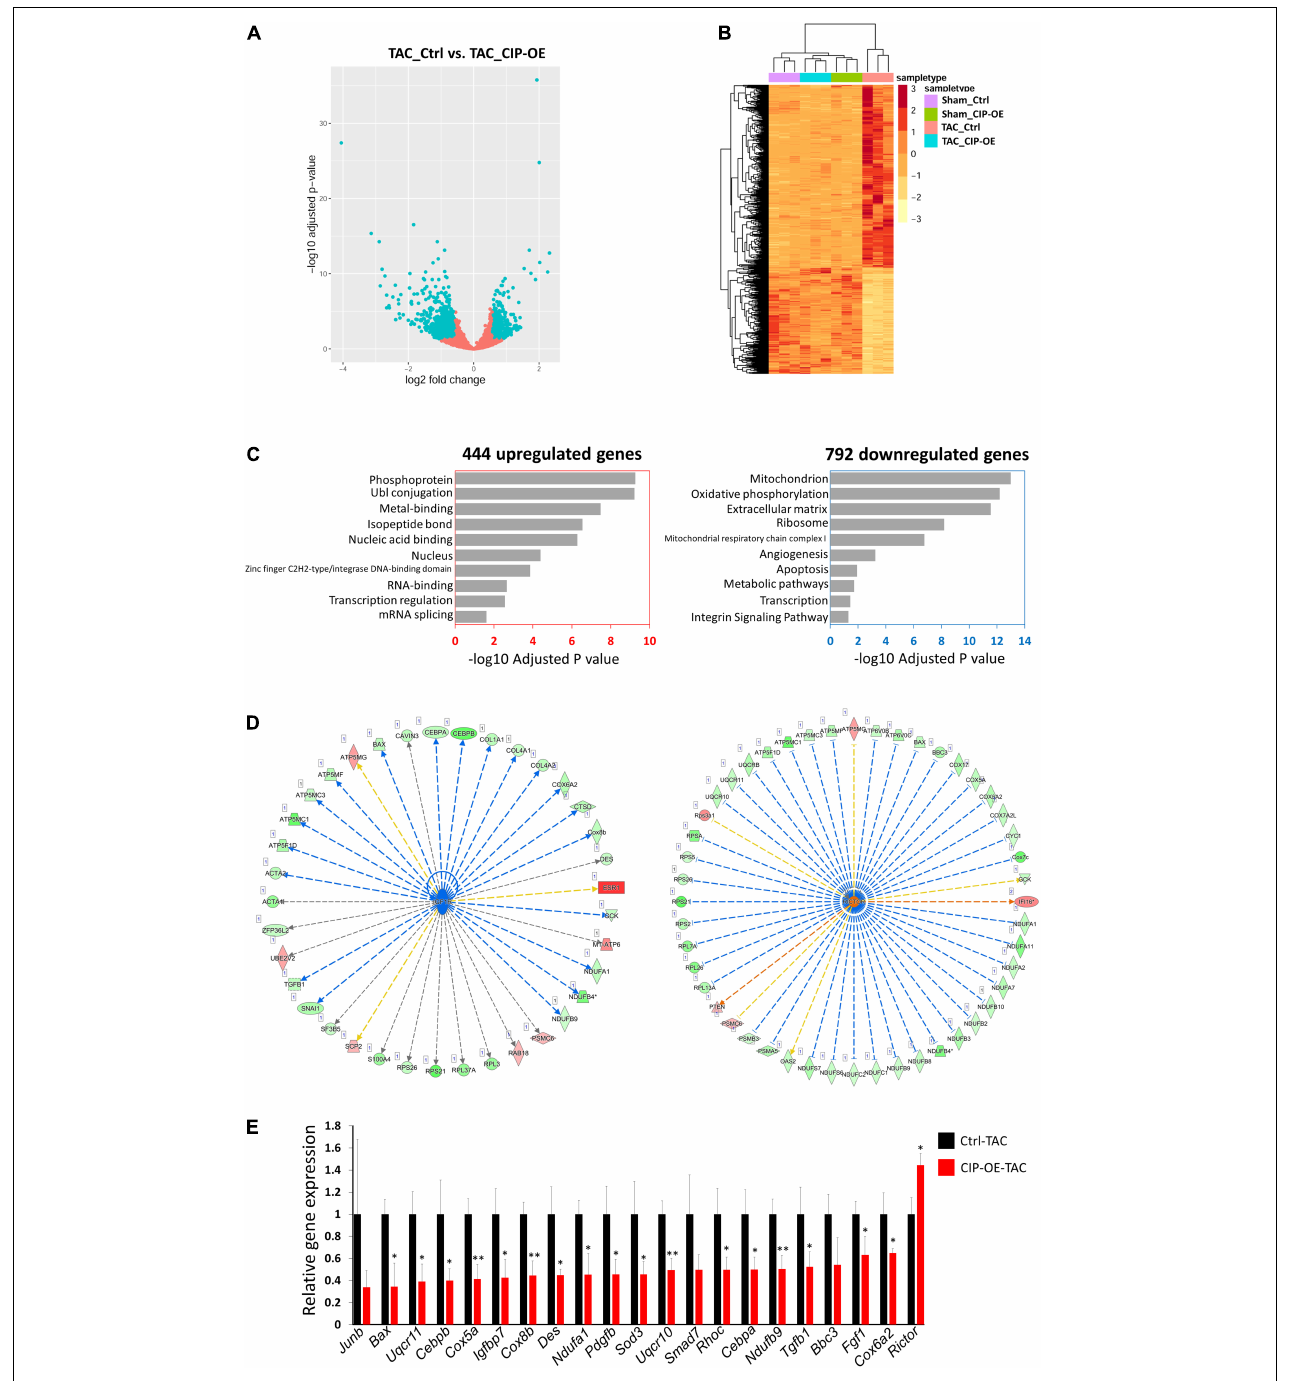
FIGURE 5 | IGF1R and mTORC2 signaling pathways mediates the function of CIP in cardiac protection. (A) A volcano plot of all detected genes in RNA-seq. Each dot represent one gene and the blue dots indicate dys-regulated genes in TAC-CIP-OE hearts comparing to TAC-Ctrl hearts. (B) A hierarchical clustering heatmap of 1,236 dys-regulated genes in all groups. (C) Gene ontology analysis of 444 up-regulated ( p < 0.05) and 792 down-regulated ( p < 0.05) genes in TAC-CIP-OE hearts. The GO terms are ranked by the adjusted P values. (D) Ingenuity Pathway Analysis (IPA) of upstream regulators of dys-regulated genes in CIP-OE heart after 8 weeks of TAC operation. Genes in green indicate their expression in CIP-OE heart is down-regulated. Genes in red indicate their expression in CIP-OE heart is up-regulated. Blue lines indicate that the dysregulation of upstream regulator lead to the down-regulation of the downstream genes, which is consistent with reported data; Red lines indicate that the dysregulation of upstream regulator lead to the up-regulation of the downstream genes, which is consistent with reported data. Yellow lines indicate that the gene regulation is inconsistent with reported data. Gray lines indicate the unknown gene regulation; (E) qRT-PCR validation of dys-regulated genes downstream of IGF1R, Rictor or TGF1B. N = 3 for each group. The significance between groups was tested with 1-way ANOVA with post hoc Tukey’s test. ∗ P < 0.05; ∗∗ P < 0.01.